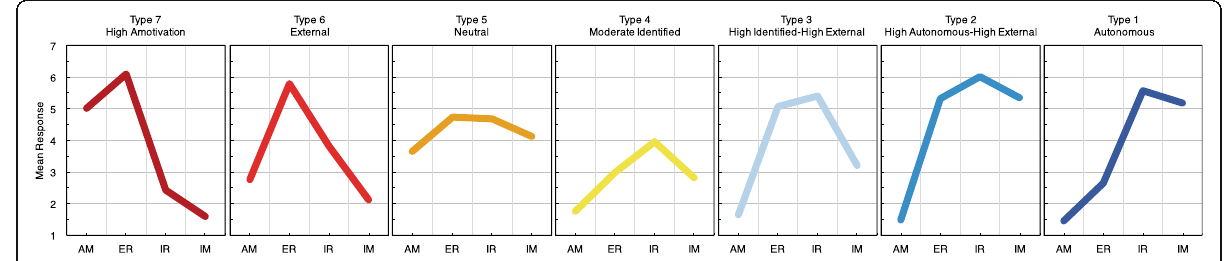
Fig. 1 Motivational response profiles identified in this study, ordered from lowest SDI (cluster AM, left) to highest SDI (cluster AU, right).